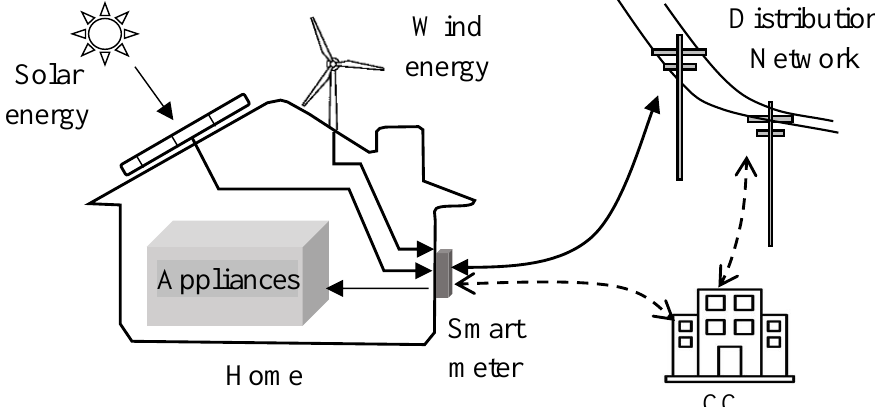
Figure 2. Renewable Energy Source (RES)-based smart metering system [20]. The solid lines denote flow of power, and the dashed lines denote the information